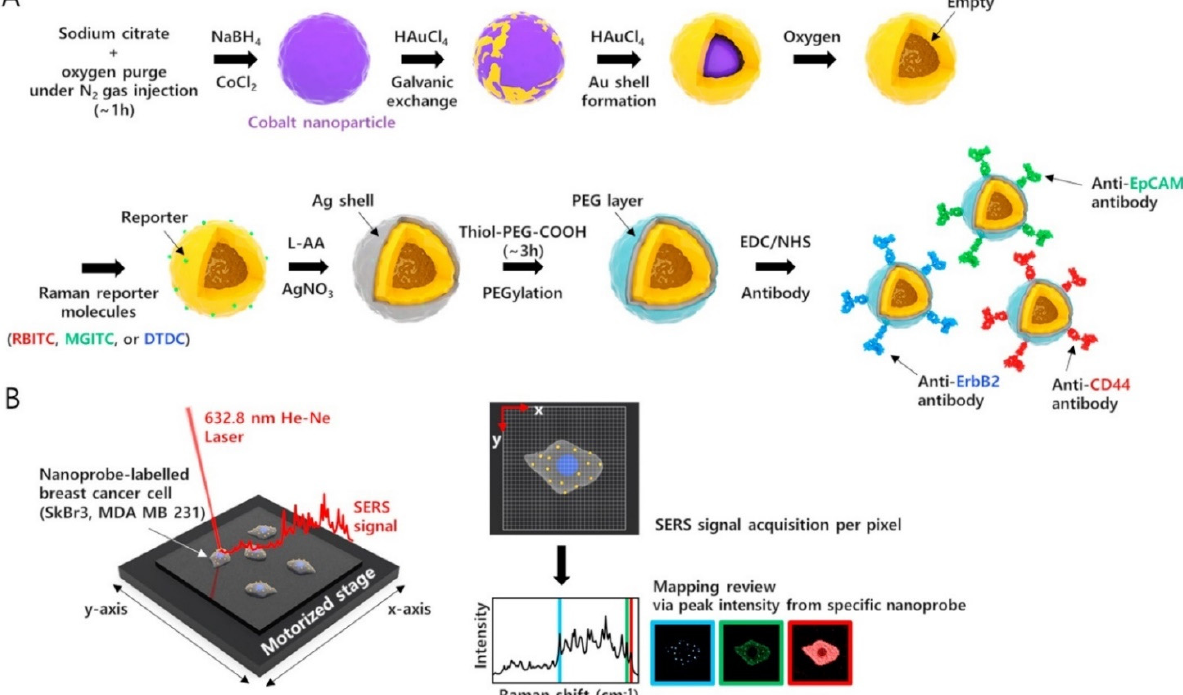
Figure 23. Schematic illustrations ( A ) for the fabrication of three different PEGylated Ag-Au hollow nanospheres, which are environmentally stable under various pH values, temperatures, and salt concentrations; and ( B ) for simultaneous detection of three different biomarkers expressed in breast cancer cells using SERS mapping techniques. Reproduced with permission from [129]. Copyright